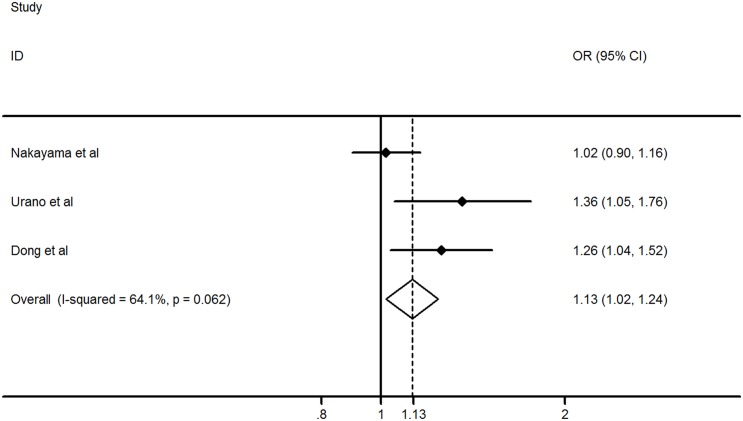
Odds ratios (ORs) and 95% confidence intervals (CI) from each study about the association of the rs2544390 polymorphism and gout in Asians.A meta-analysis in fixed-effect model was used to test the association.